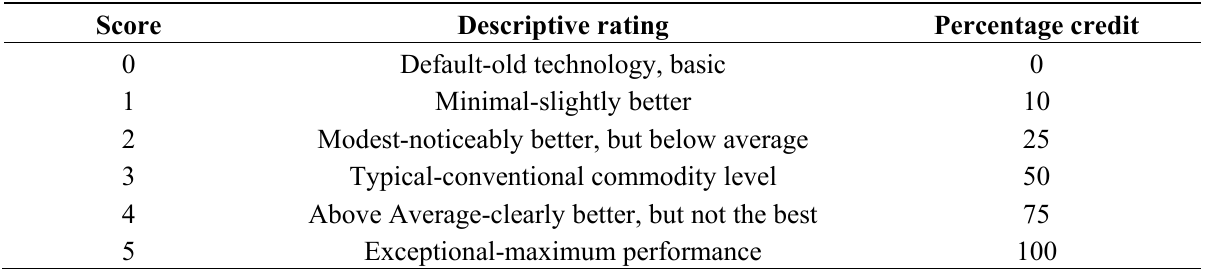
Table 3. BDI category